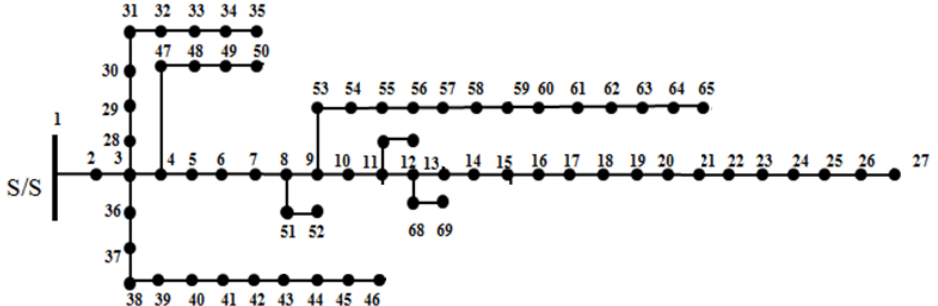
Figure 7. IEEE 69-bus network configuration. Table 7. The resulting optimal values through different optimizers applied to the IEEE 69-bus.